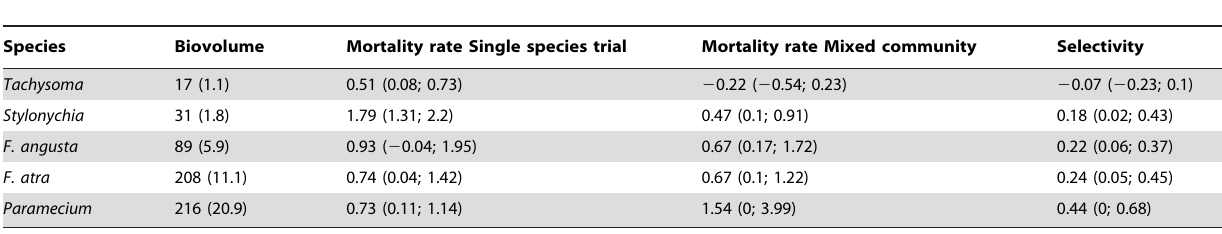
Table 2. Ciliate biovolume (10 3 m m 3 ; n =15), mortality rate (day 2 1 ) in the single prey species experiment, and mortality rate and selectivity in the mixed prey species